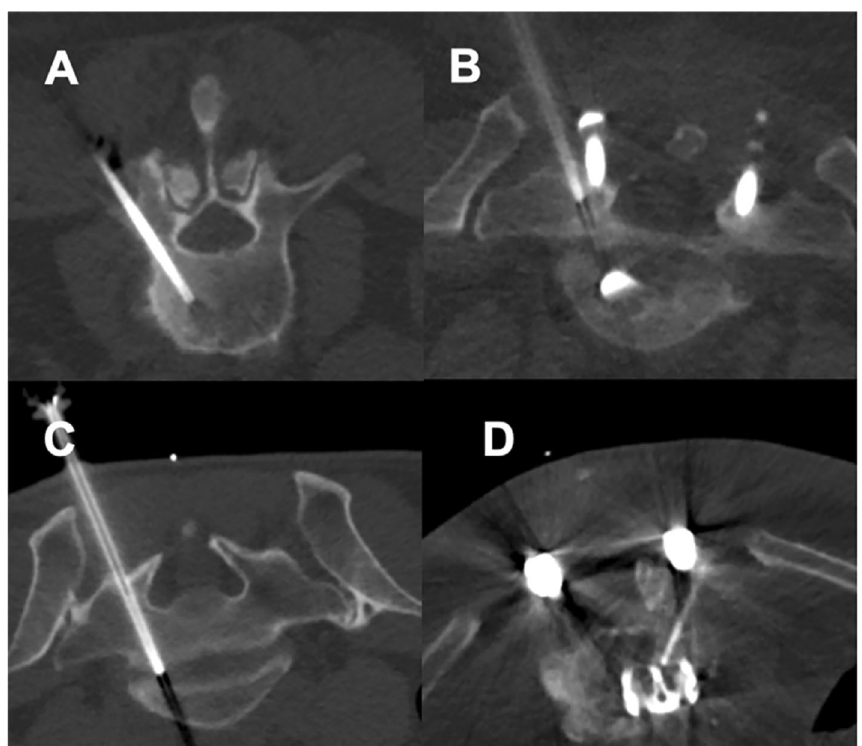
Figure 5. Exemplary patient cases for intervertebral disc biopsies using scanning with standard dose (SD; A , B ) and scanning with low dose (LD; C , D ). The upper row shows a L2/3 intervertebral disc biopsy in a 66-year- old woman ( A ) and a L5/S1 intervertebral disc biopsy in a 58-year-old woman with artifacts due to spinal instrumentation ( B ). The second row shows a L5/S1 intervertebral disc biopsy in a 48-year-old male patient ( C ) and a L4/5 intervertebral disc biopsy in an 80-year-old man with artifacts due to spinal instrumentation ( D ). All patients underwent intervertebral disc biopsy due to suspected